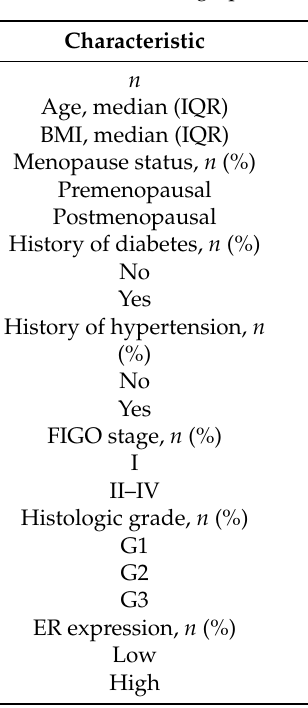
Table 1. Patient Demographics and Clinical Characteristics with CSI in EC